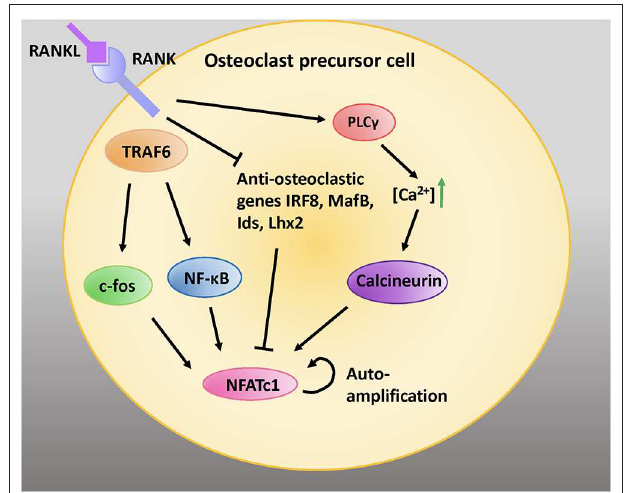
FIGURE 2 | RANK/RANKL signaling is critical for osteoclastic differentiation and function. RANKL binding to RANK expressed on the cell surface of preosteoblastic cells activates intracellular adaptor protein TRAF6. Activation of c-fos and NF- κ B pathways induces the NFATc1 gene. Moreover, activation of PLC γ increases intracellular calcium concentrations; this activates the protein calceineurin, which leads to recruitment of NFATc1 to its own promoter which further induces NFATc1. RANK signaling inhibits the anti-osteoclastic genes interferon regulatory factor 8 (IRF8), V-maf avian musculoaponeurotic fibrosarcoma oncogene homolog B (MafB), inhibitors of differentiation (Ids), and LIM homeobox 2 (Lhx2), which inhibit NFATc1 expression. Adapted from Kim and Kim, J Bone Metab , 2014